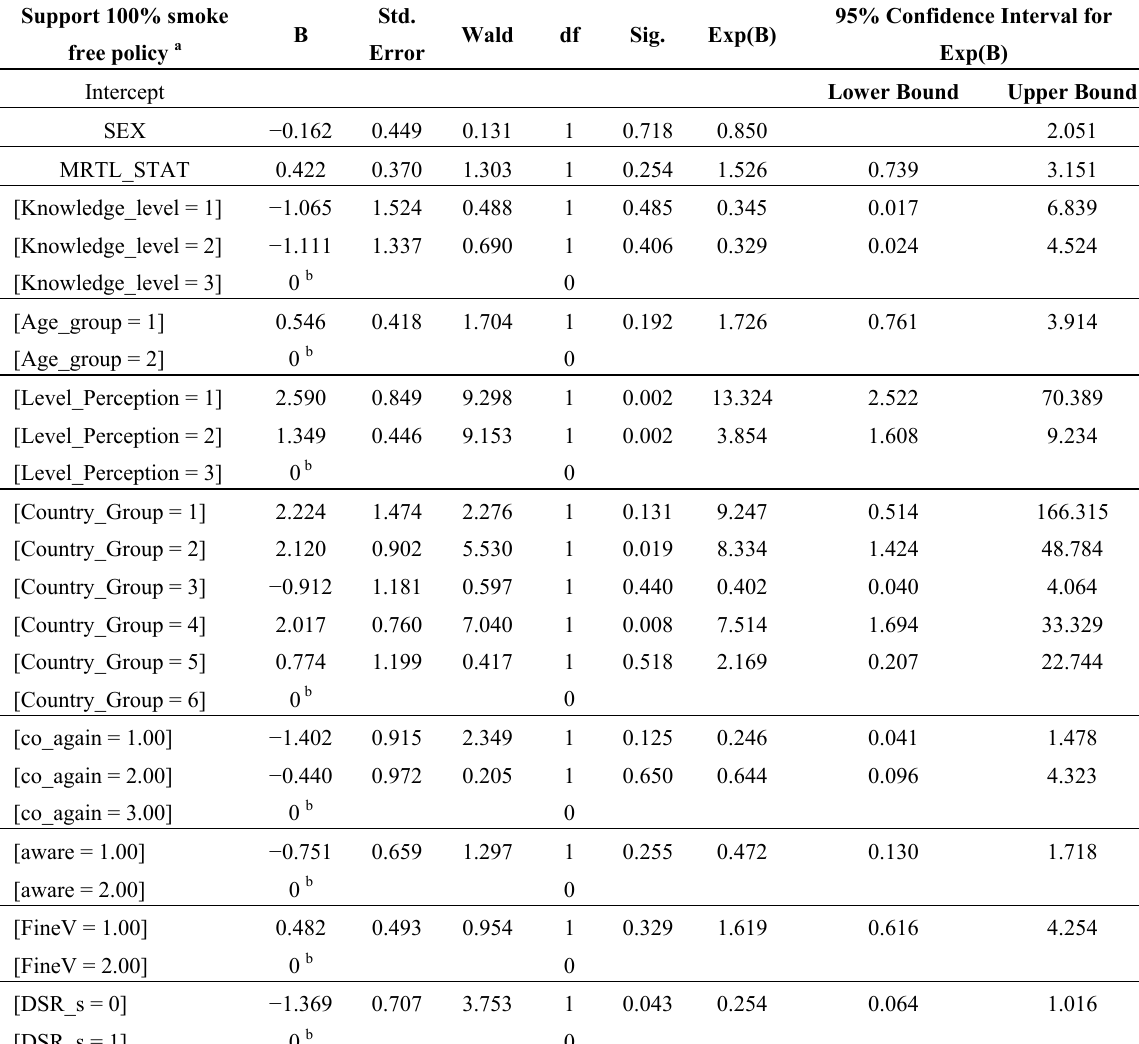
Table A4. Parameter